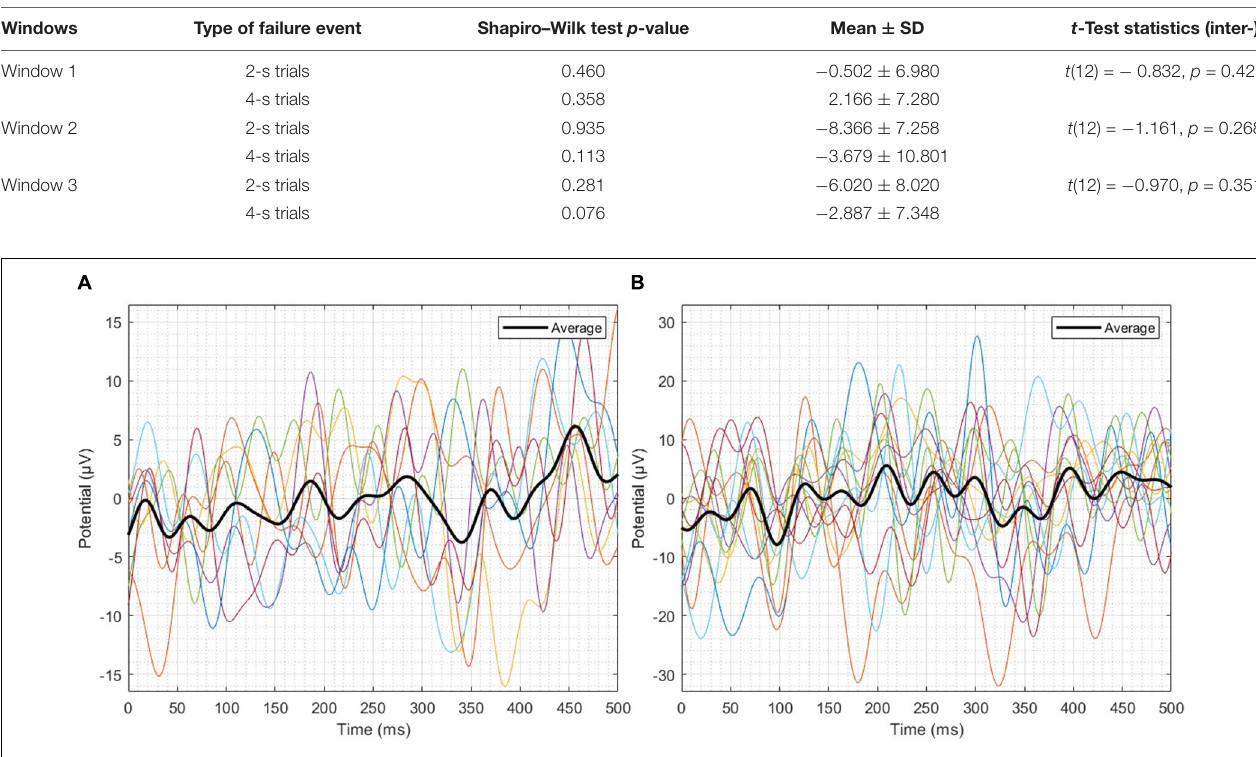
FIGURE 6 | Single-trial EEG responses of patient 2. (A) Failure trials, (B) Success trials. In the three-time windows W1, W2 and W3, the average ITC of the failure trials has been observed to be 0.3486, and for the success trials, it has been observed to be 0.4187.